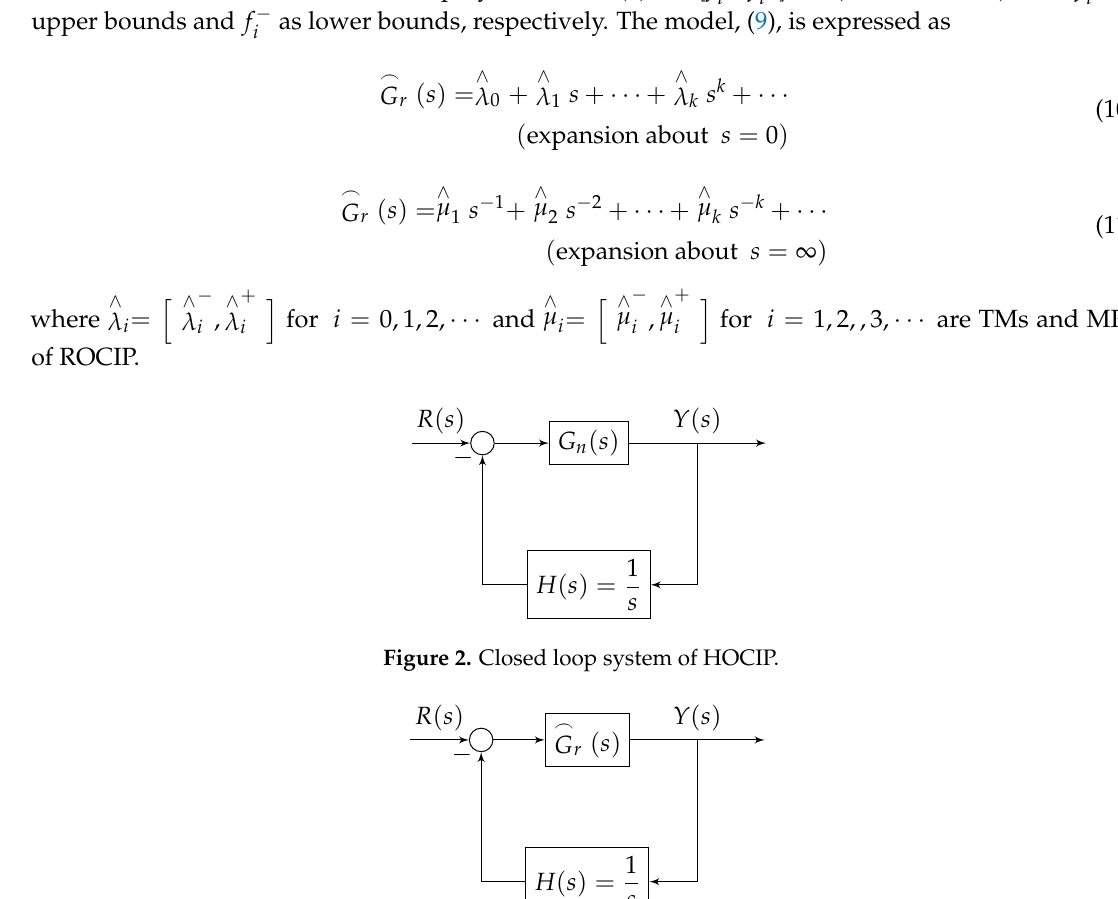
Figure 3: Closed-loop system of reduced-order continuous interval plant (ROCIP).